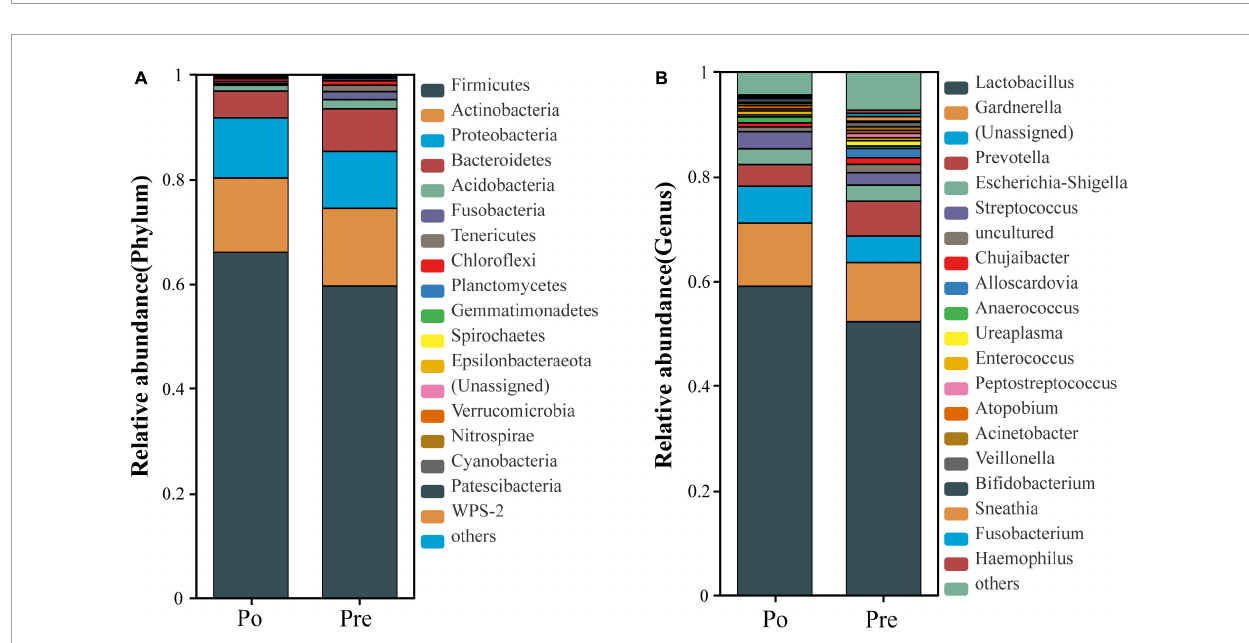
FIGURE2 Composition of the vaginal microbiota. Comparison of the average abundance of each bacterial phylum in the pre-operative and post-operative groups (A) . Comparison of the average abundance of each bacterial genus in the pre-operative and post-operative groups (B)